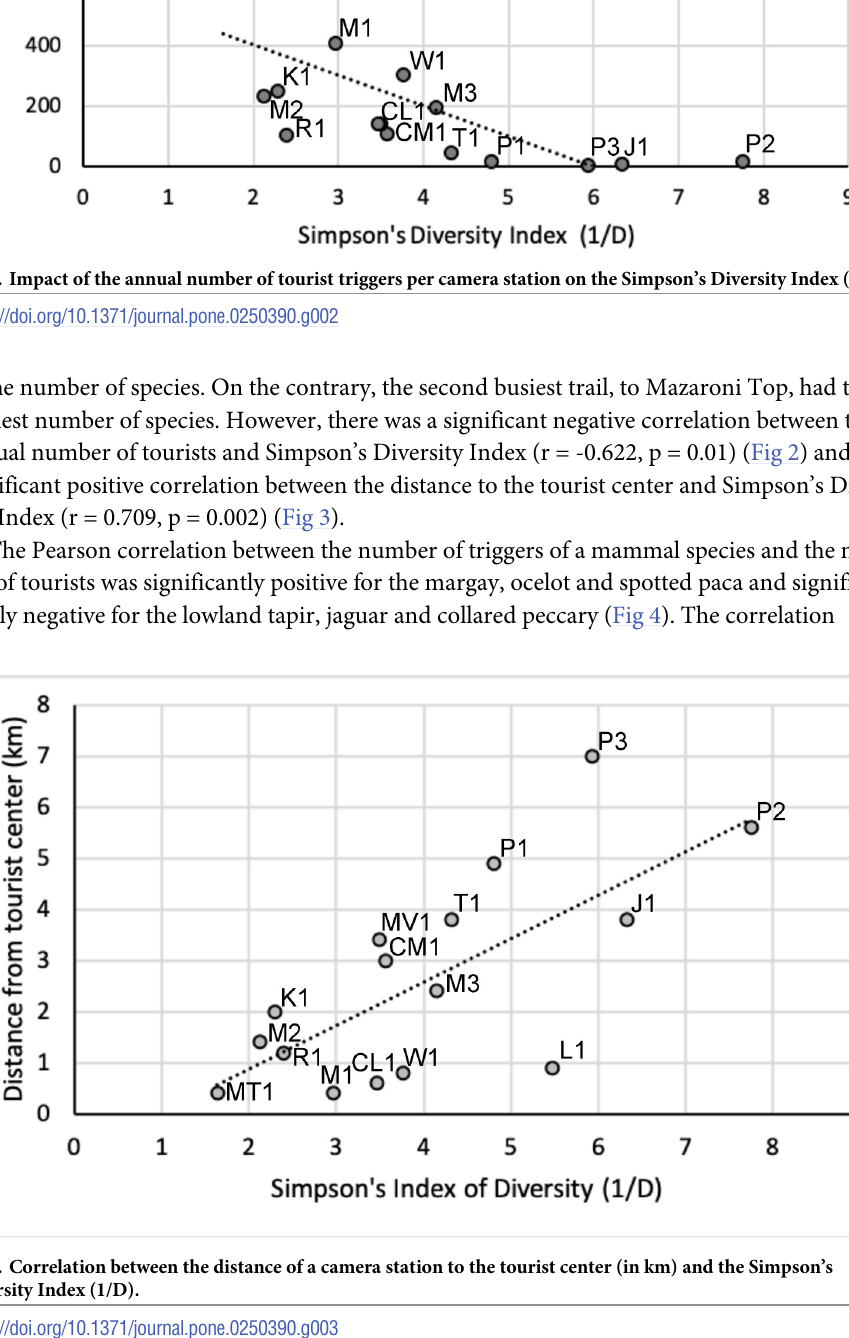
Fig 3. Correlation between the distance of a camera station to the tourist center (in km) and the Simpson’s Diversity Index (1/D).